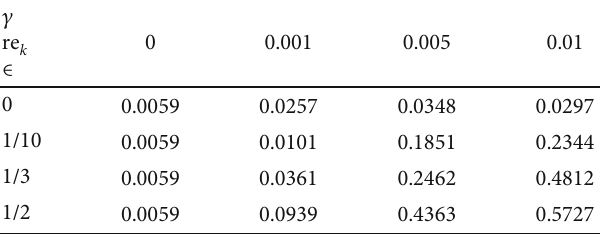
ff erent noise levels ϵ and index Table 2: The relative error re k with di of penalty term γ for α = ð 0 : 8,0 : 6,0 : 1 Þ in Example 16.